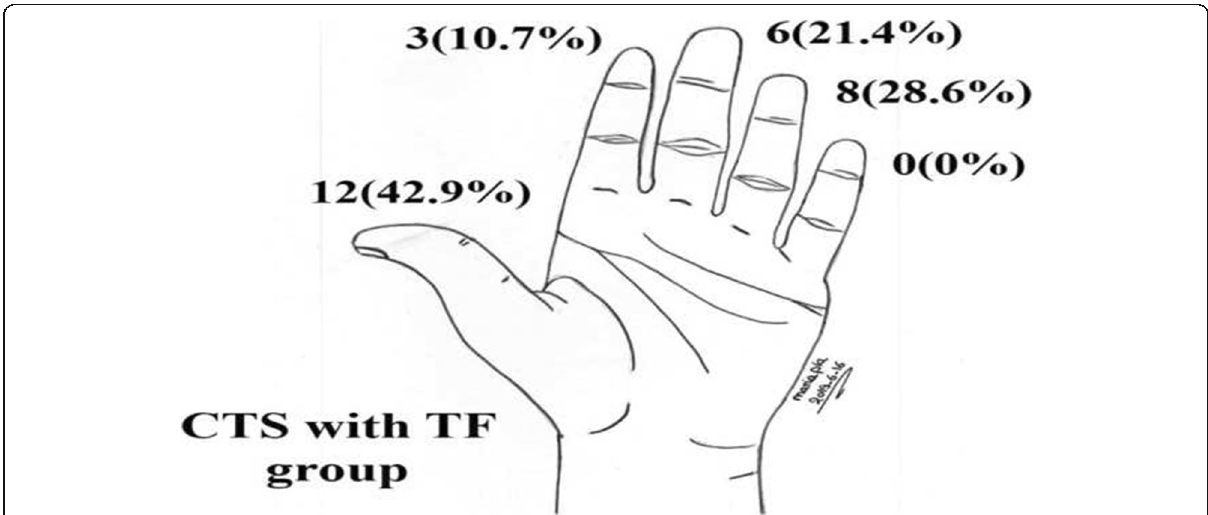
Fig. 9 Distribution of trigger fingers among different fingers in the hands of the carpal tunnel syndrome with trigger finger (TF) group ( n = 28 hands from 24 patients). There was one hand (3.6%) of a patient (4.2%) which had two fingers with TF (thumb TF and ring TF). This hand was mentioned twice (once with thumb TF and the other time with ring TF). Subsequently, the counted number of the hands in the figure was 29 hands. CTS , carpal tunnel syndrome; TF, trigger finger; number (percentage), number (percentage) of